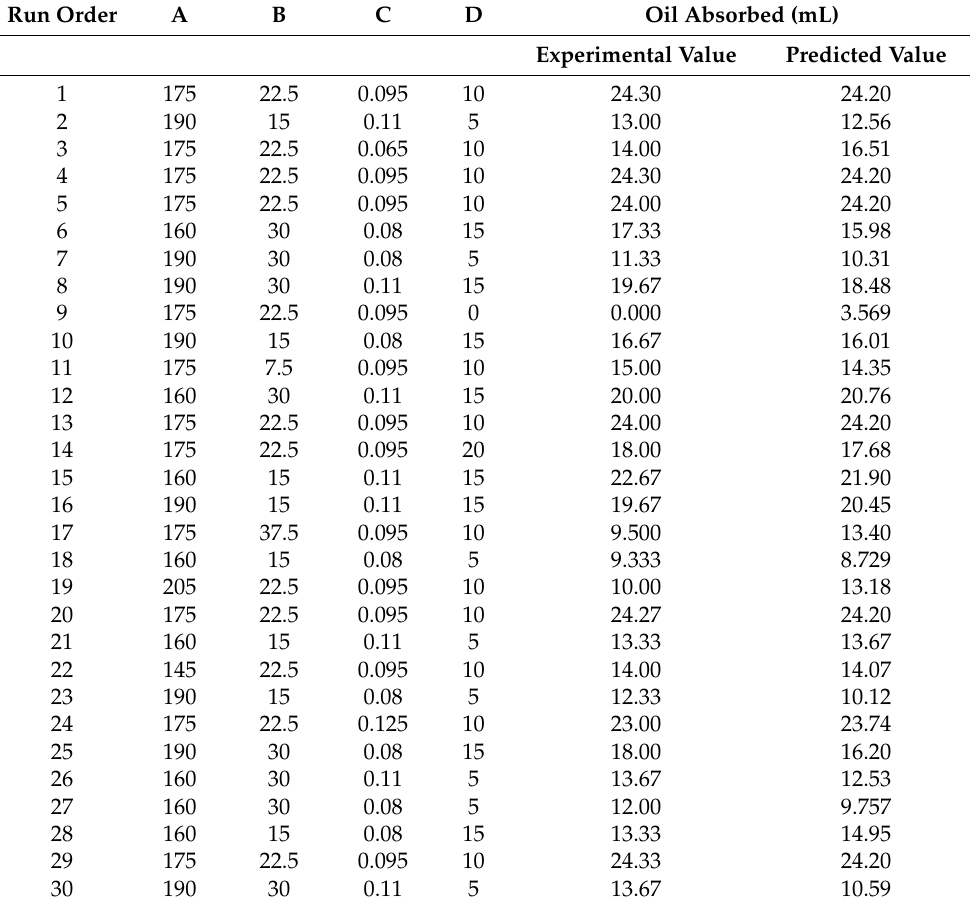
Table 5. Optimisation of parameters for diesel sorption by EFB fibre using central composite de- sign